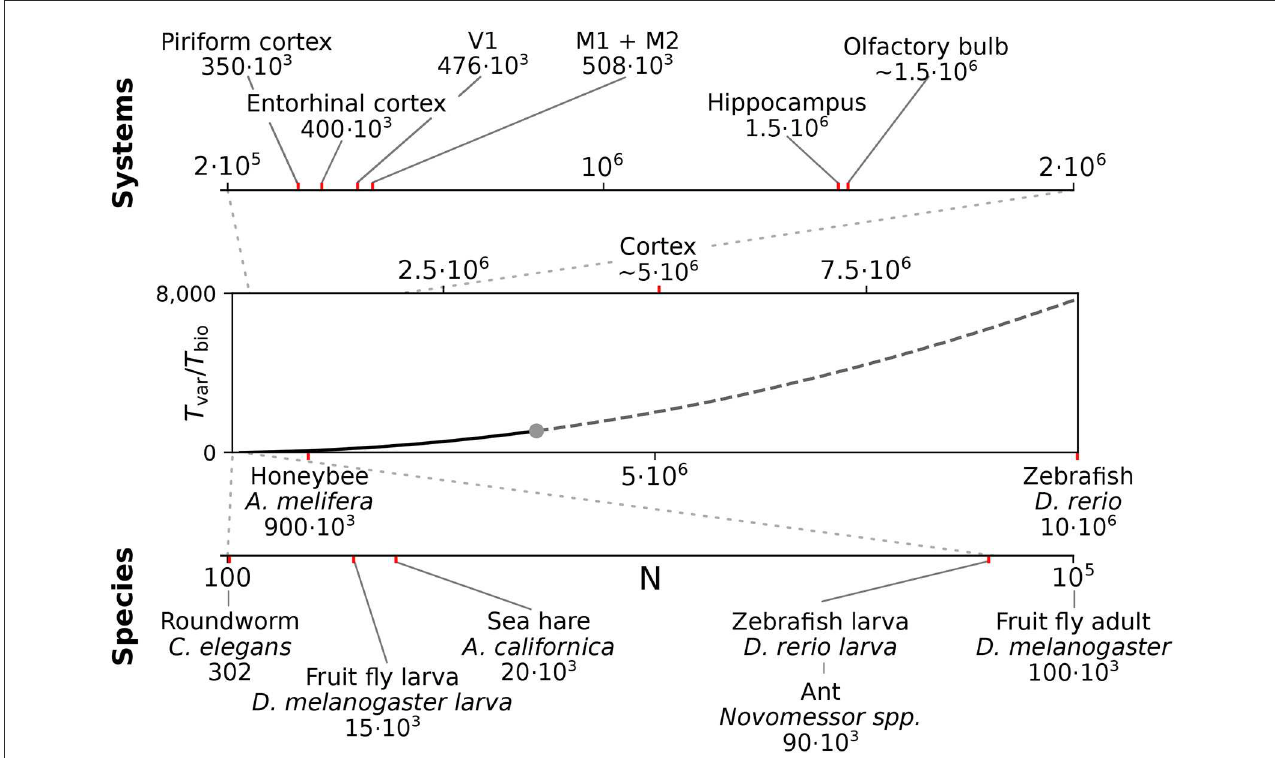
FIGURE6 Full system modeling with spiking neurons. Wall-clock time relative to simulated biological model time T var /T bio over a realistic range of network sizes for spiking network simulation. Network size is projected to the total number of neurons per hemisphere for subsystems in the mouse (top) and in the CNS of invertebrate and small vertebrate model species (bottom) ; (see also Table 5). The graph sketches the quadratic dependence on network size N for large N fitted for the PROCEDURAL connectivity simulation method with GeNN (Figure 3, see Section Materials and methods). The solid line shows the range of network sizes covered in our simulations (cf. Figure 2) using a high-end GPU with 48GB RAM (S3, Table 2). The dashed line extrapolates to a maximum size of 10 million neurons assuming larger GPU RAM that would allow to cover the neocortex of the mouse and the complete CNS of the